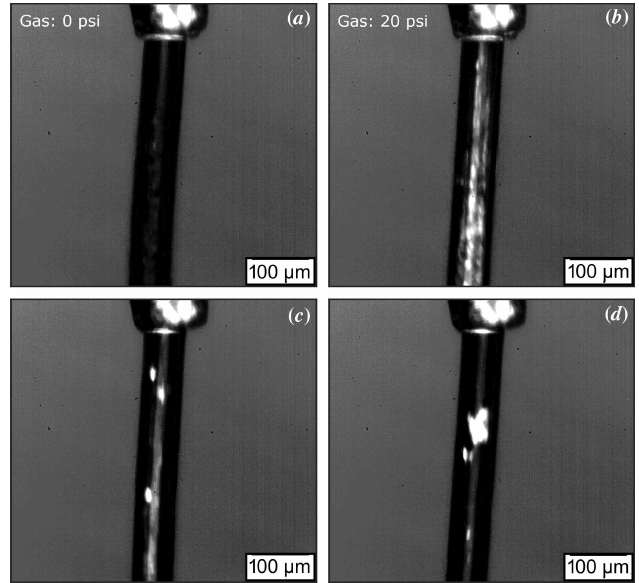
Figure 6 Images of the sample stream taken in air with the sample between crossed polarisers. Bright regions of the images indicate the presence of the polarizing lamellar phase. The sample composition is 60:40 MO/water ( w / v ) and the nozzle diameter is 75 m m. ( a ) Stabilizing gas sheath turned off and sample is in a non-polarizing cubic phase. ( b ) Gas sheath on with backing pressure of approximately 20 psi. Brightness of the sample indicates the presence of lamellar phase. ( c , d ) The appearance of isolated lamellar regions not associated with changes in gas pressure. These are likely caused by air bubbles within the sample and are consistent with the transient appearance of L (cid:2) observed in the X-ray data.